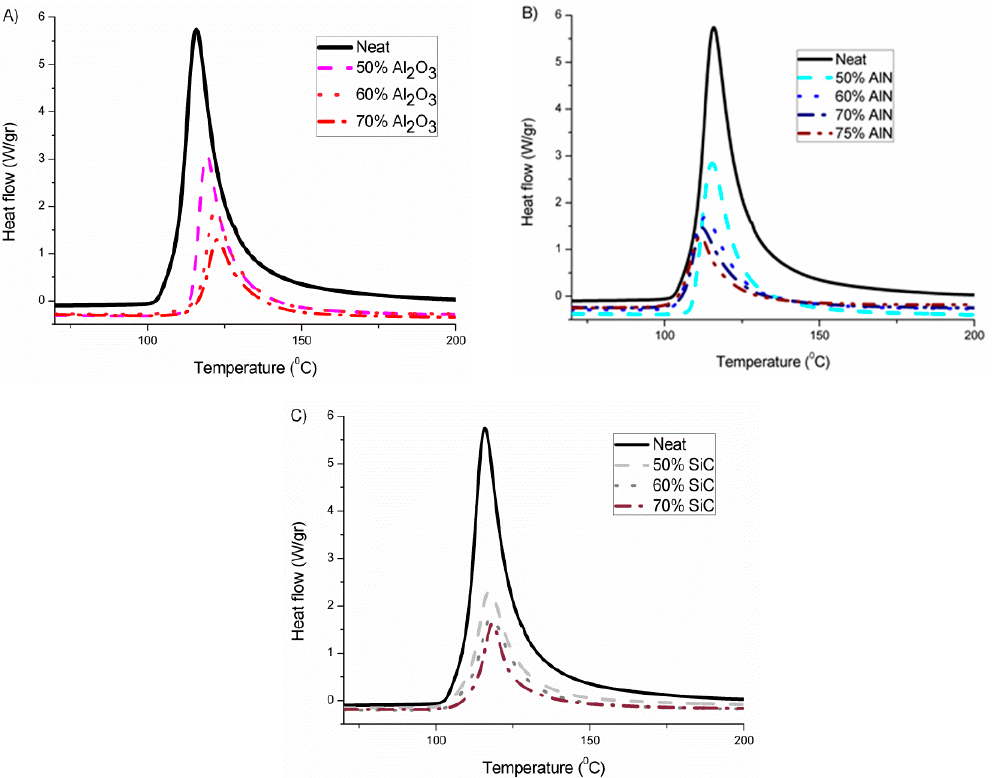
Figure 1. Exothermic curves from differential scanning calorimetry (DSC) analysis of all the mixtures prepared with different fillers: ( A ) Al 2 O 3 ; ( B ) AlN; ( C ) SiC.